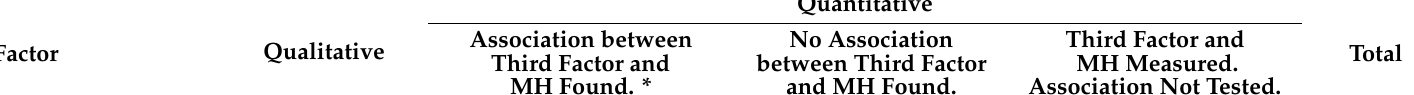
Quantitative No Association TotalAssociation between Third Factor and between Third Factor Third Factor and MH Measured. and MH Found. MH Found. * Association Not